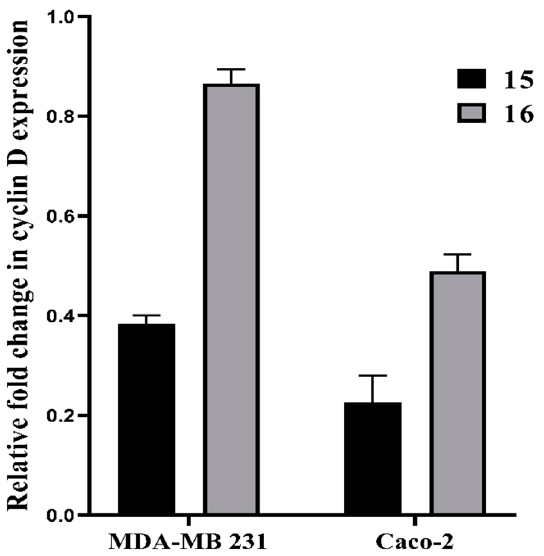
Figure 4. Relative fold change in cyclin D expression in MDA-MB 231 and Caco-2 cells after treatment with 15 and 16 at their respective IC 50 concentrations. All values are expressed as mean ± SEM.